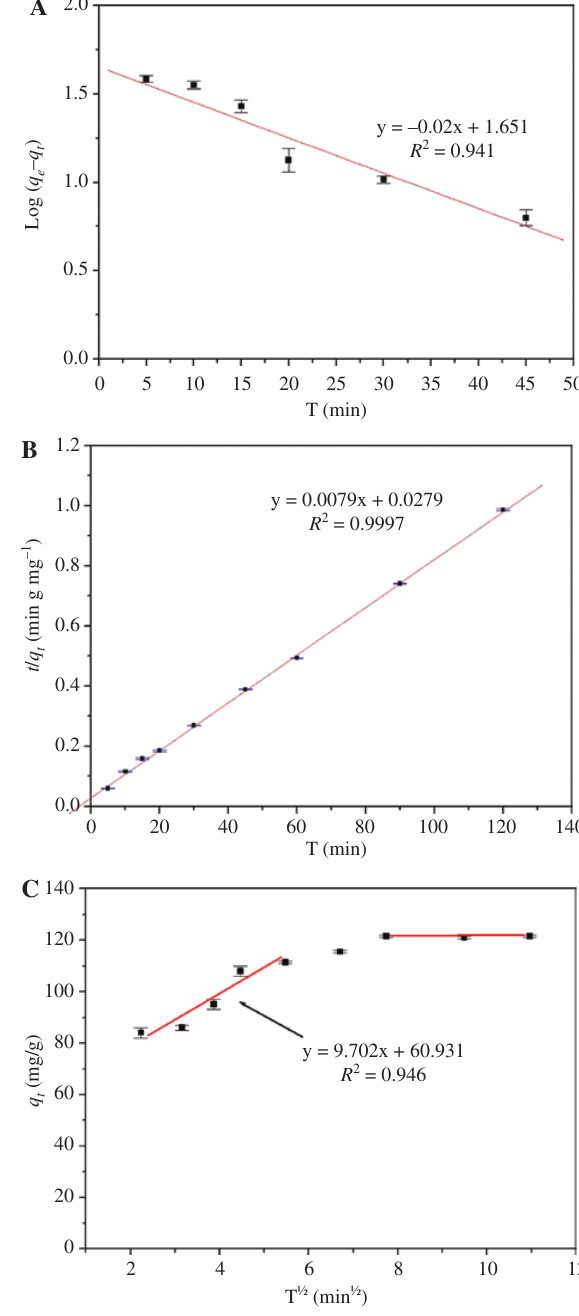
Figure 2: Adsorption data modeled using three kinetic models: (A) Lagergren’s pseudo-first order law, (B) McKay and Ho’s pseudo- second-order law, and (C) the intra-particle diffusion